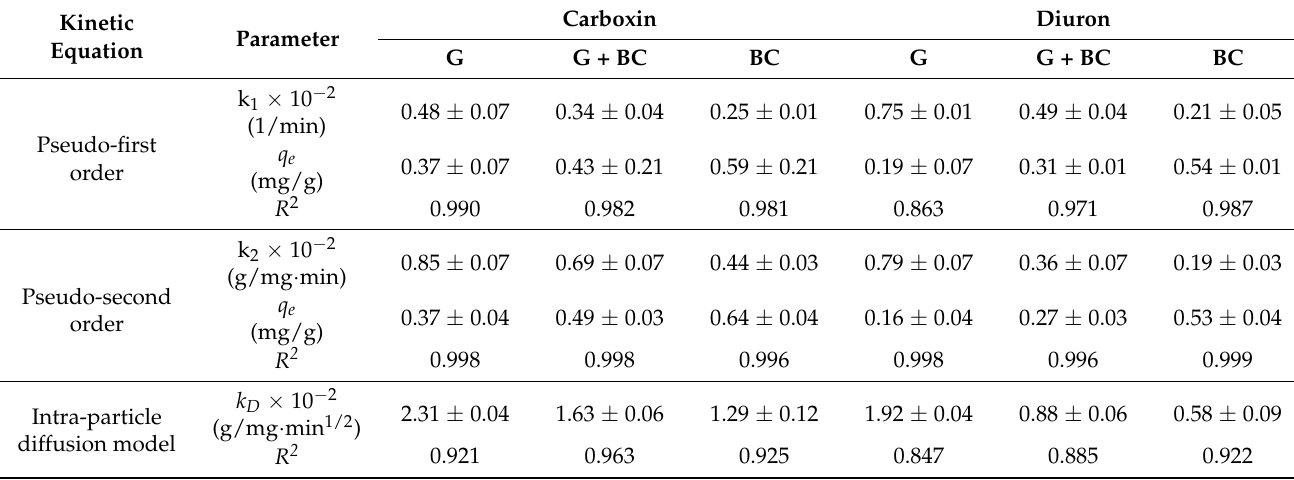
Table 3. Kinetic parameters of pesticides adsorption on goethite (G), biochar (BC) and goethite–biochar mixture (G + BC).